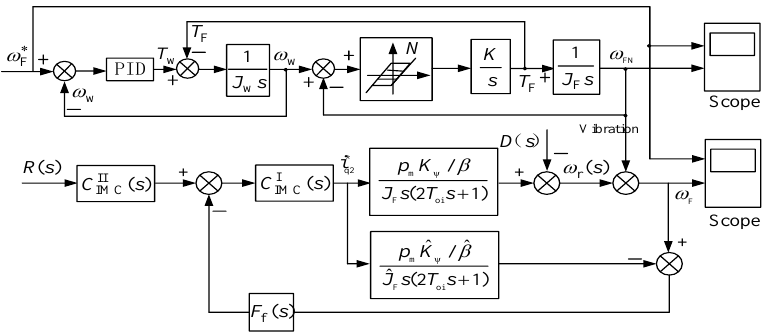
Figure 18. Experimental simulation model of drivetrain vibration suppression based on the 3-DOF- IMC of generator. * means the reference value.